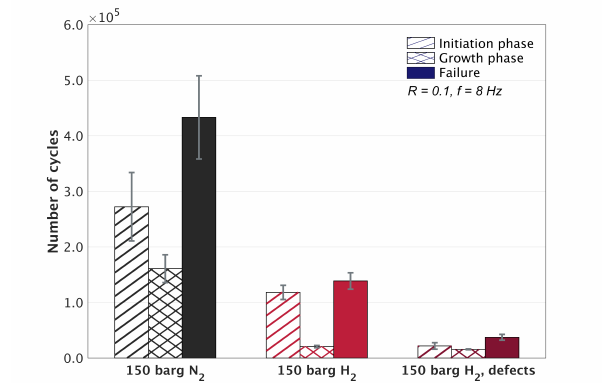
Figure 11. Bar graph of the number of cycles spent in the crack initiation phase ( N I ) and the growth phase ( N G ), and the total number of cycles until failure ( N F ) of the weld metal specimens including defected ones. The different conditions tested are shown with distinct colors. The single and double hatched bars represent the number of cycles spent in the initiation and growth phase, respectively. Error bars are standard